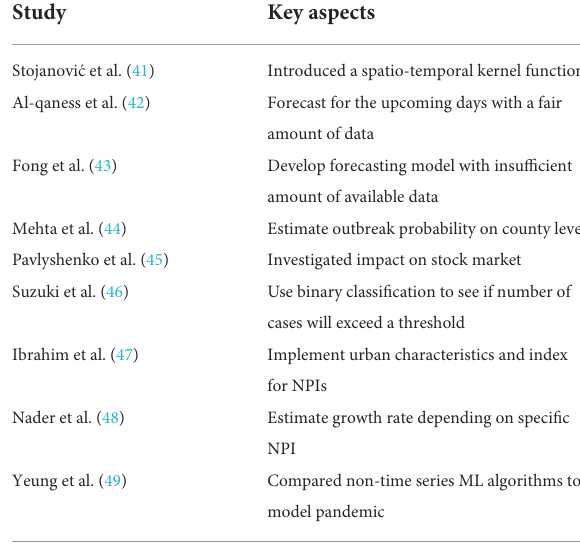
TABLE 2 Included studies covering spatio-temporal monitoring of disease spread with compartmental models and their key aspects.